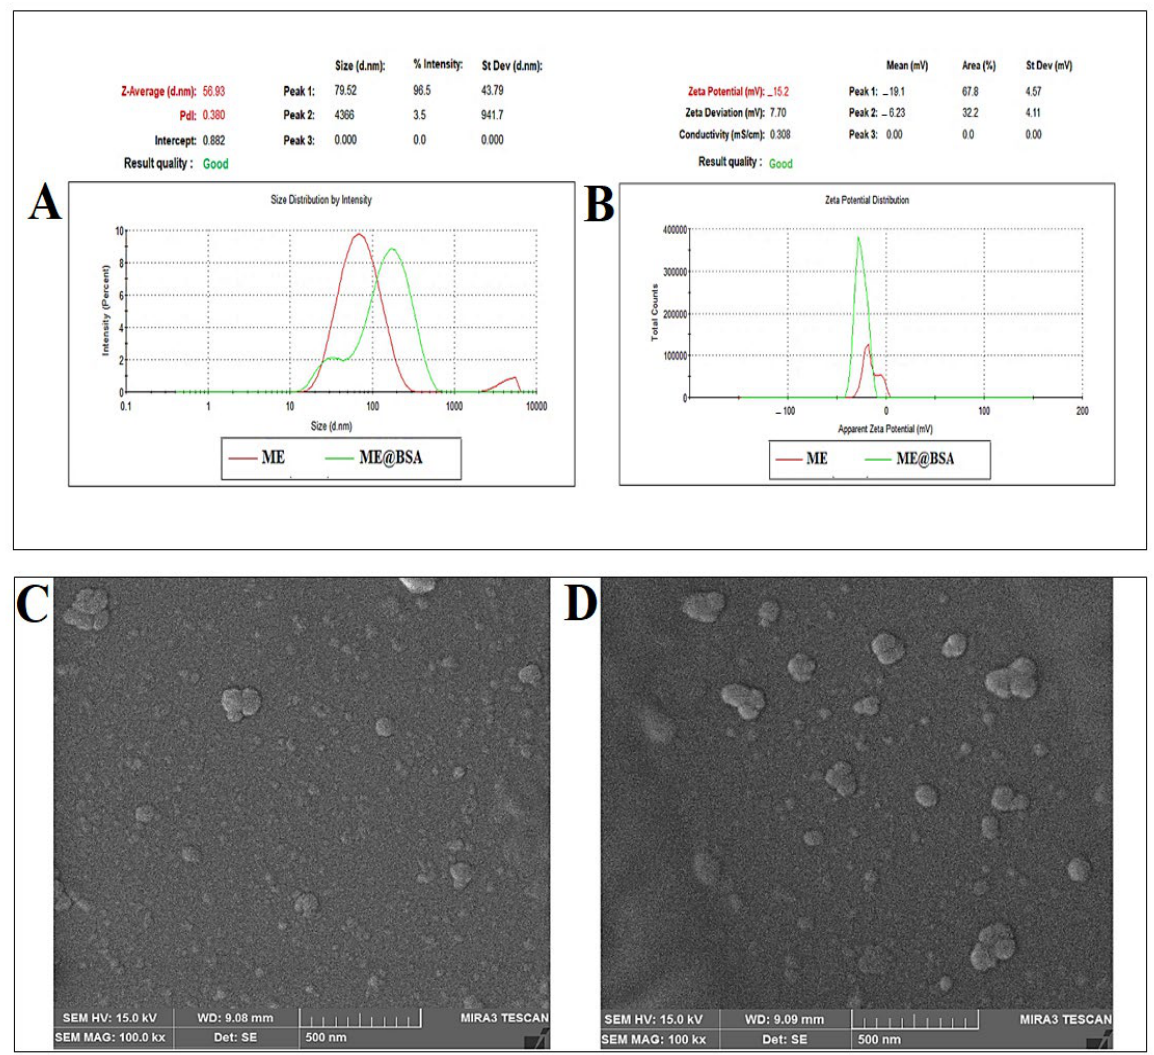
Figure 4. ( A ) DLS-based size distributions for the ME and ME@BSA; ( B ) ζ -potential of ME and ME@BSA; ( C ) electron micrograph (FE-SEM) showing the ME formulation, and ( D ) FE-SEM micro- graph of the formulation ME@BSA.